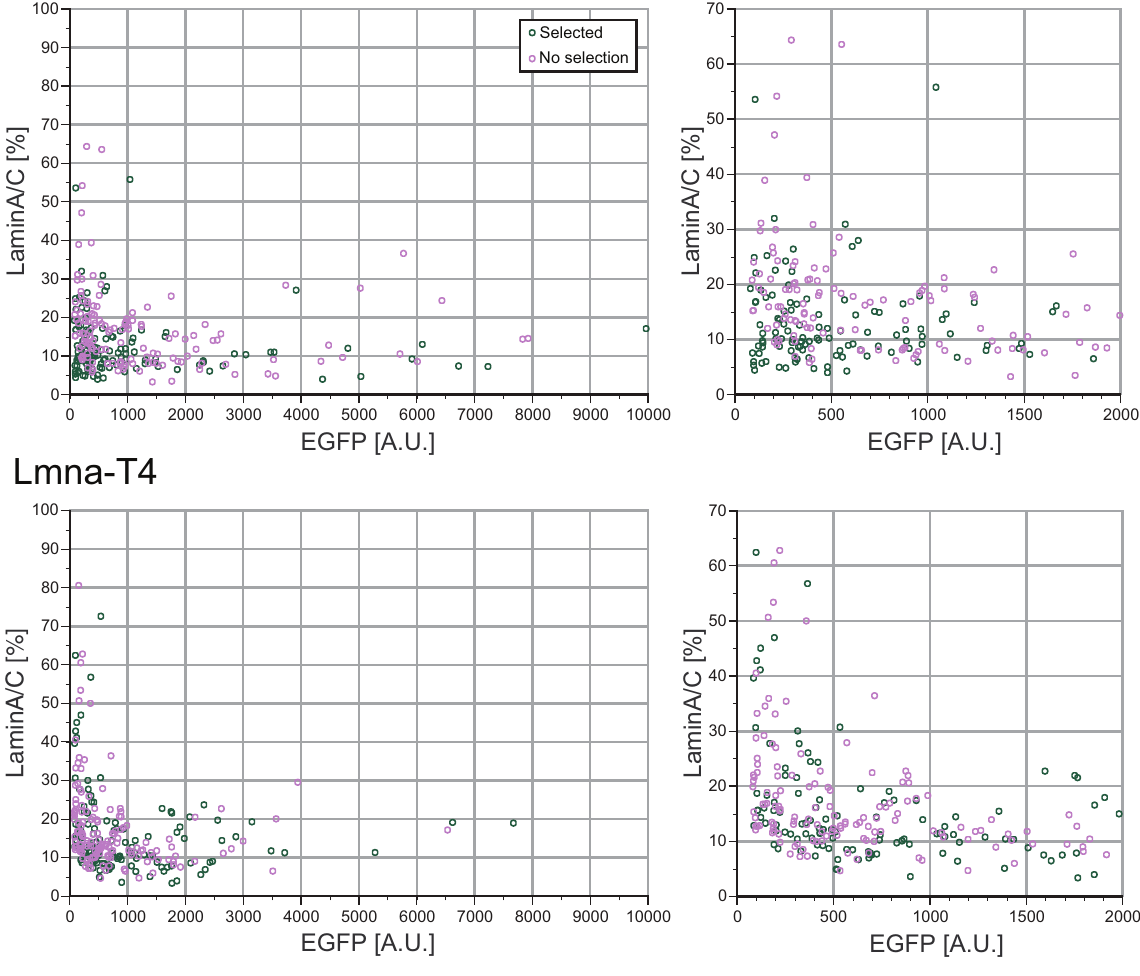
Supplemental Figure 8. Scatter plots for RNAi of laminA/C. HeLa cells were transfected with pSHIN-G-Lmna-T1 or -T4. Five days after, laminA/C was immunostained. The fluorescence intensity of lamin A/C-staining was normalized to the average of untransfected cells that did not express EGFP. The left and right graphs use different scales for the same data set. The relationship between the EGFP intensities and the remaining lamin A/C levels [%] are shown as scatter plots. The shRNA expression plasmids were prepared by using the two methods described as in Figure 4A. The simplified method without colony-selection (purple dots) was compared with the conventional method (green dots). There was no significant difference between plasmids prepared using the two